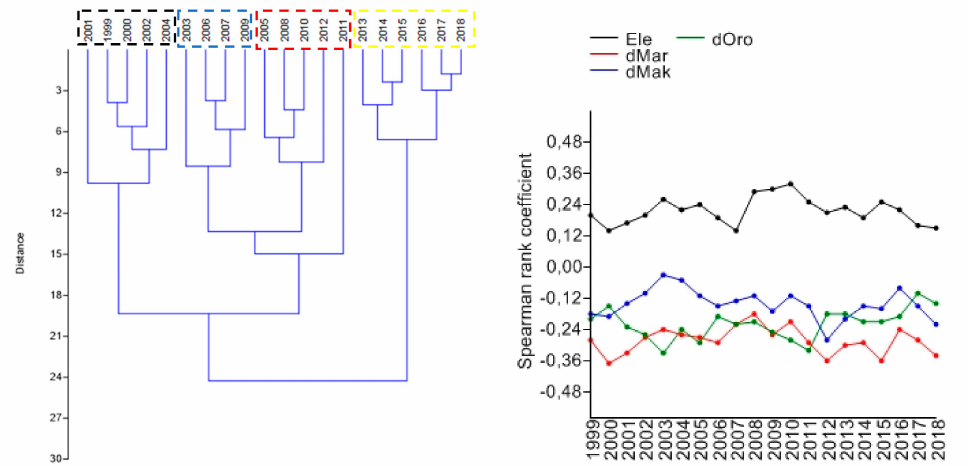
Figure 10. Hierarchical clustering (Ward’s agglomeration; Euclidean distance) assessing similarity in the temporal distribution of crude rates of natural change of population (annual percent rate by municipality) in the study area; color boxes indicate years belonging to four homogeneous groups ( left ) and pair-wise Spearman rank correlation coe ffi cients between natural population balance and selected predictors of the socioeconomic profile of municipalities (significance at p < 0.05 with r s > | 0.27 | , n = 115) ( right